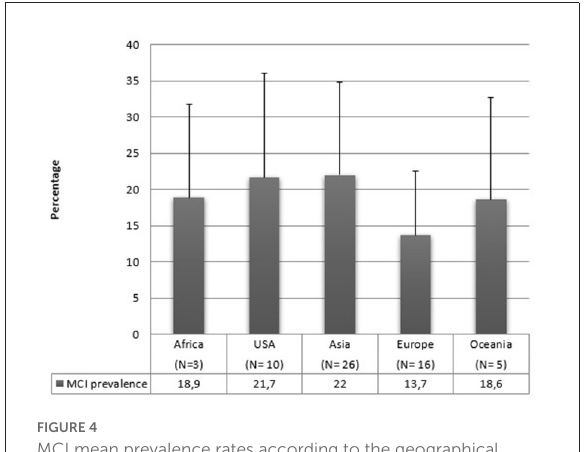
FIGURE4 MCI mean prevalence rates according to the geographical region of